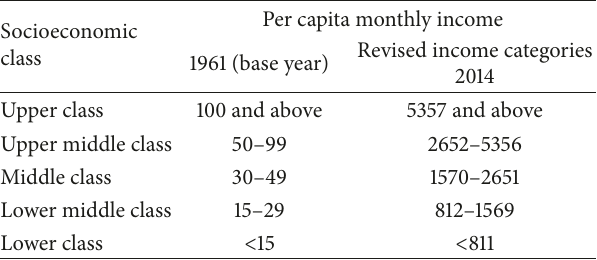
Table 1: Revised modified BG Prasad socioeconomic classification scale, January 2014.